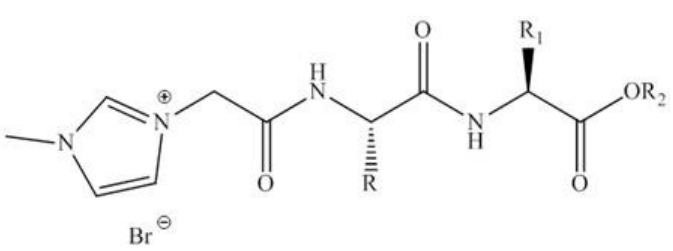
Figure 4. General structure of dipeptide ILs